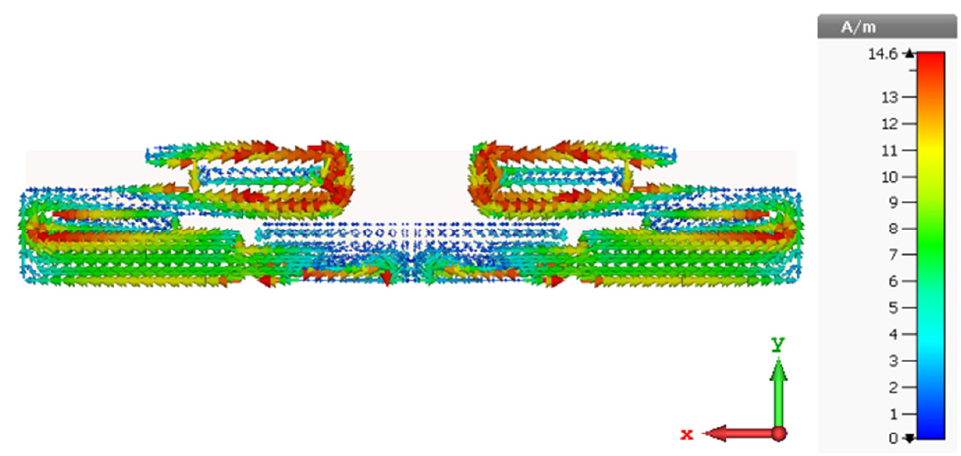
Table 2. Optimised dimensions of the proposed monopole